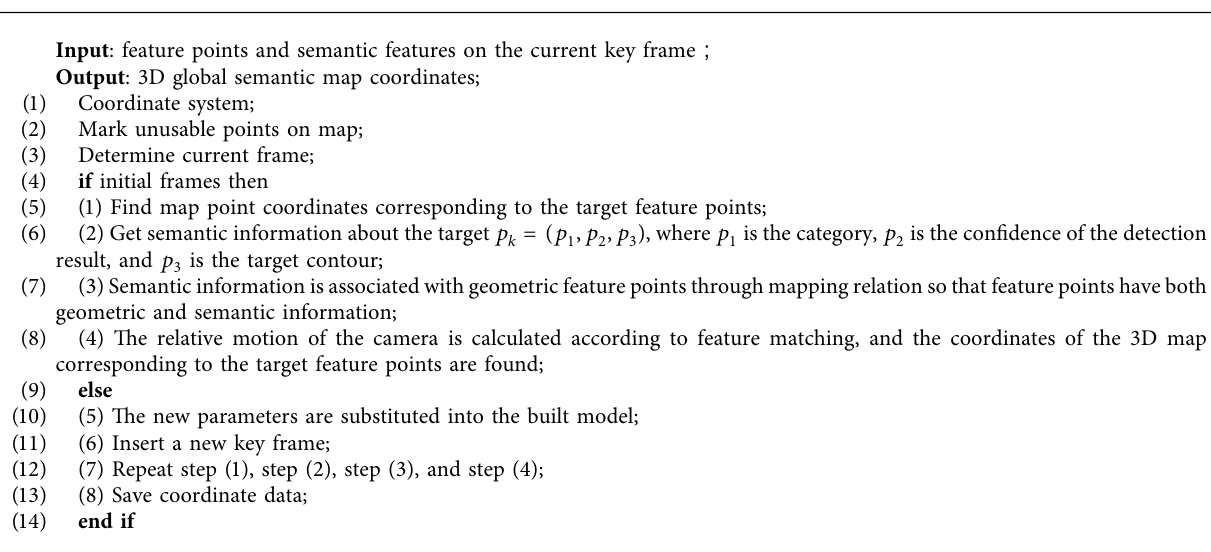
A LGORITHM 3: Data association and fusion